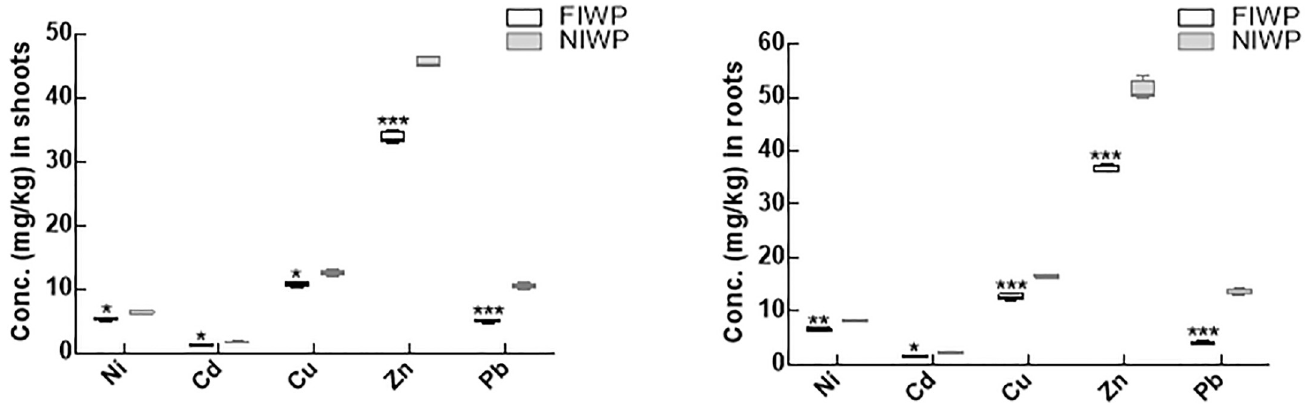
Fig 7. Heavy metals concentration of CGF-1 inoculated and non-inoculated wheat plants. Fig 7A represents heavy metal concentration in shoots of CGF-1 inoculated and non-inoculated wheat plant grown in contaminated soil; Fig 7B represents heavy metal concentration in roots of CGF-1 inoculated and non- inoculated wheat plant grown in contaminated soil; FIWP = fungal inoculated wheat plant; NIWP = non-inoculated wheat plant; Ni = nickel; Cd = cadmium; Cu = copper; Zn = zinc; Pb = lead. The experiment was carried out in triplicate, each replicate comprised of 10 pots and each pot contained 6 seedlings (total = 6 × 10 × 3 = 180 seedlings per treatment). Means of fungal inoculated wheat plants (FIWP) were compared with non-inoculated wheat plants (NIWP); ‘ ��� ’ represents significant difference at P = 0.0005; ‘ �� ’ represents significant difference at P = 0.005; ‘ � ’ represents significant difference at P = 0.05.